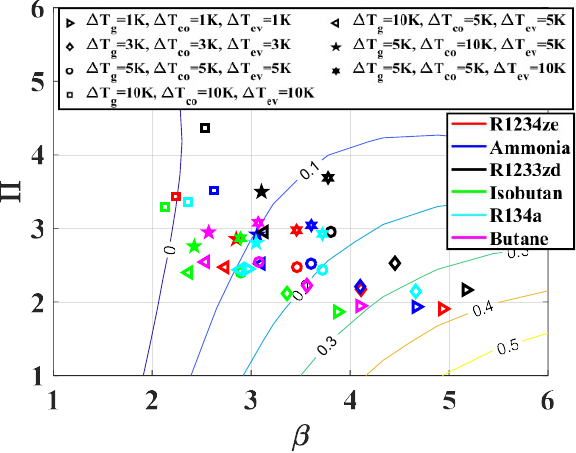
Figure 5. System COP (contour plot) as function of beta ratio and pressure lift for different pinch point values at the heat exchangers.